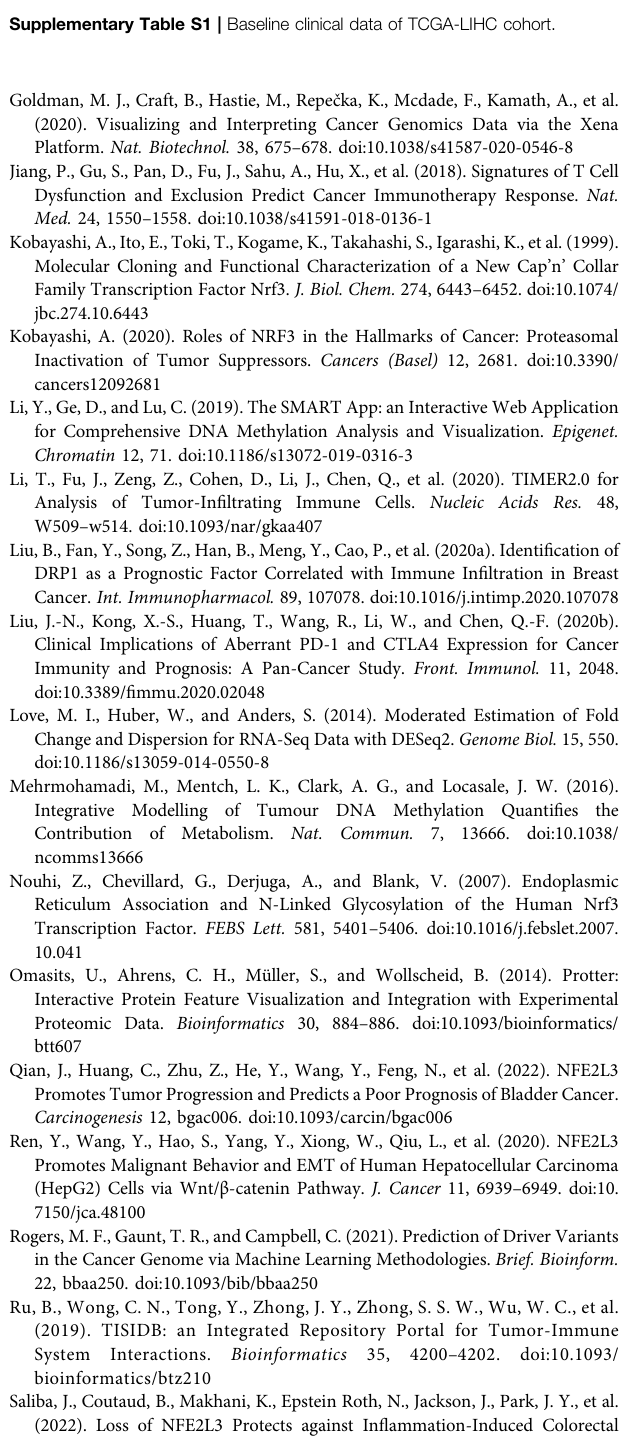
Supplementary Figure S1 | The correlation of NFE2L3 expression and disease- speci fi c survival (DSS) in pan-cancer.